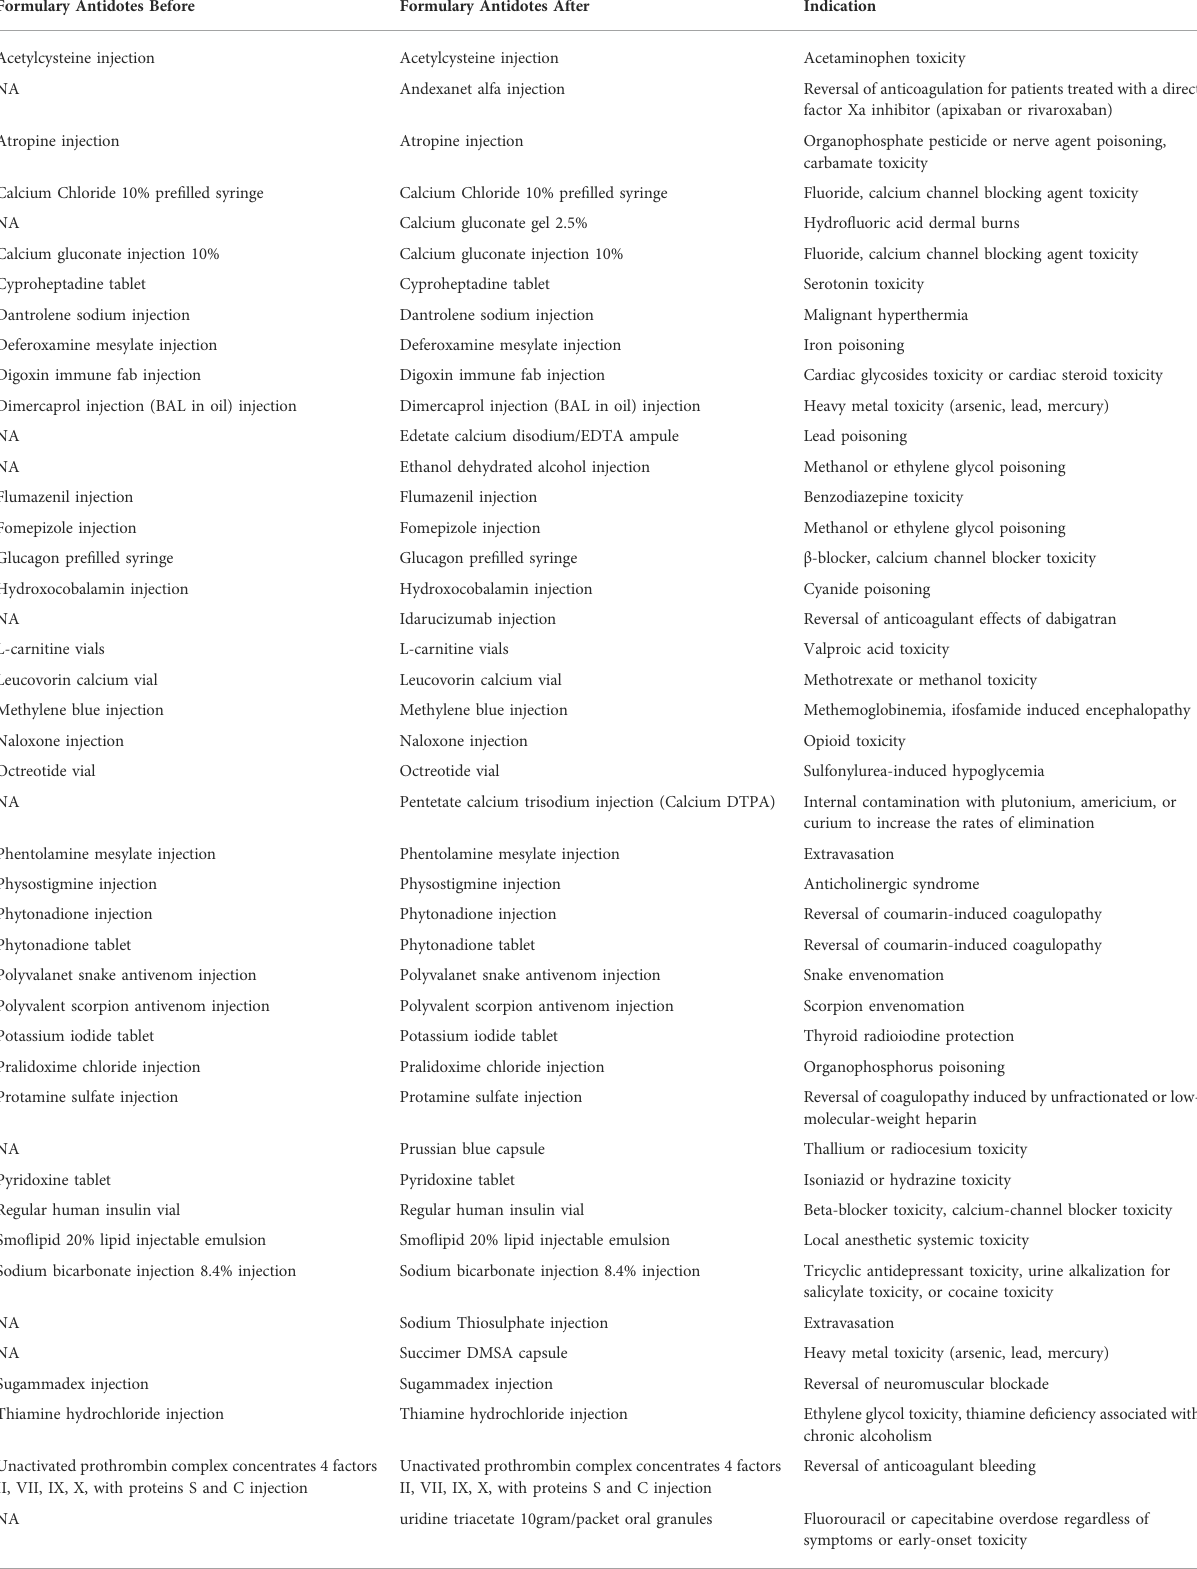
TABLE 2 List of Antidotes on the Formulary before and after the RCA. Formulary Antidotes